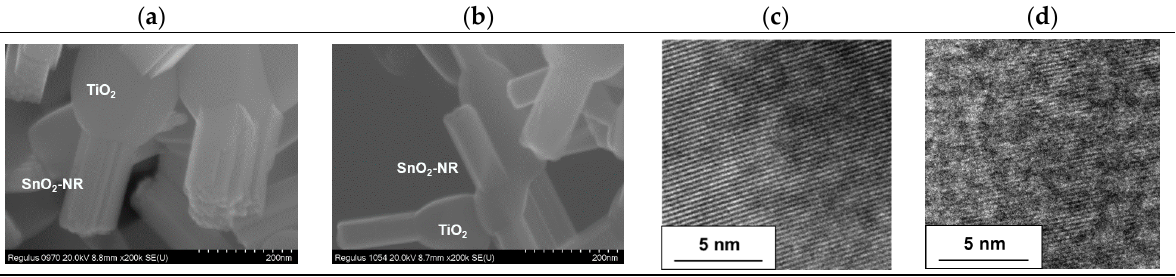
Figure 5. SEM images of SnO 2 -NR#TiO 2: ( a ) as-grown ( b ) T c = 500 °C. HR-TEM image of the SnO 2 -NR moiety of SnO 2 - NR#TiO 2 : ( c ) T c = 500 °C, ( d ) T c = 700 °C. The figure is taken from ref. [17].